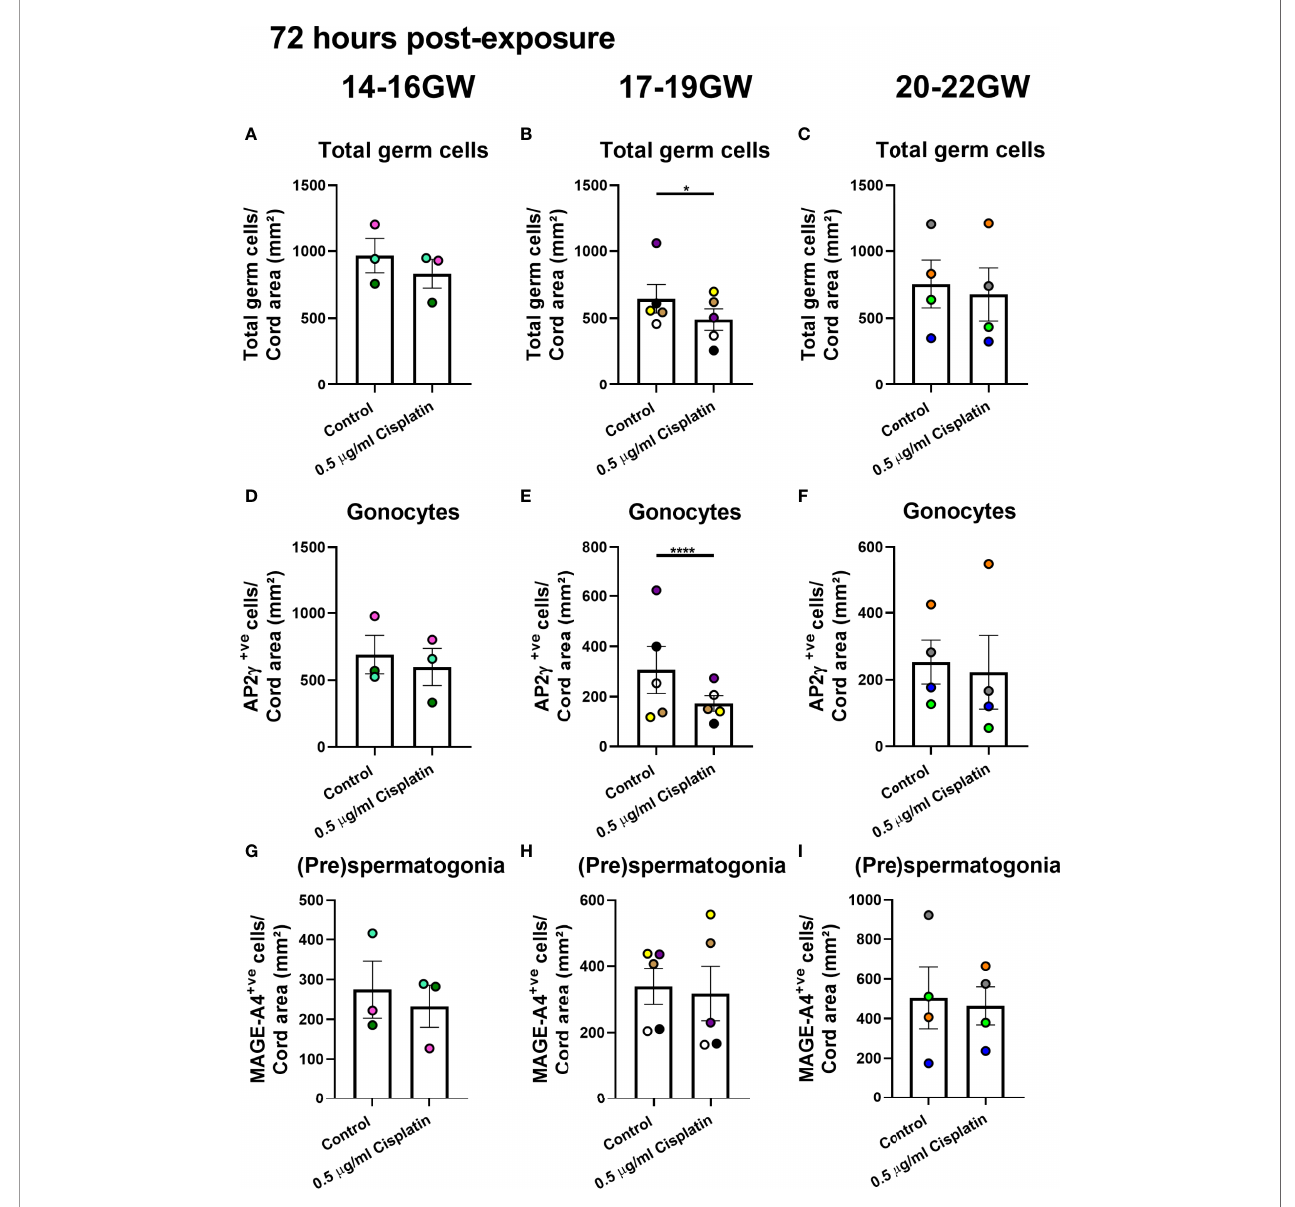
FIGURE 3 | Effects of exposure to cisplatin on germ cell number in human fetal testicular tissues at 72 hours post-exposure according to gestational age. Total number of germ cells in early- (A) , mid- (B) and late- (C) second trimester human fetal testis. Gonocyte number in early- (D) , mid- (E) and late- (F) second trimester human fetal testis. (Pre)spermatogonial number in early- (G) , mid- (H) and late- (I) second trimester human fetal testis. Data analysed using two-way ANOVA. *p<0.05, ****p<0.0001. Values shown are means ± SEM and each data point represents the mean value for all fragments obtained from an individual fetus